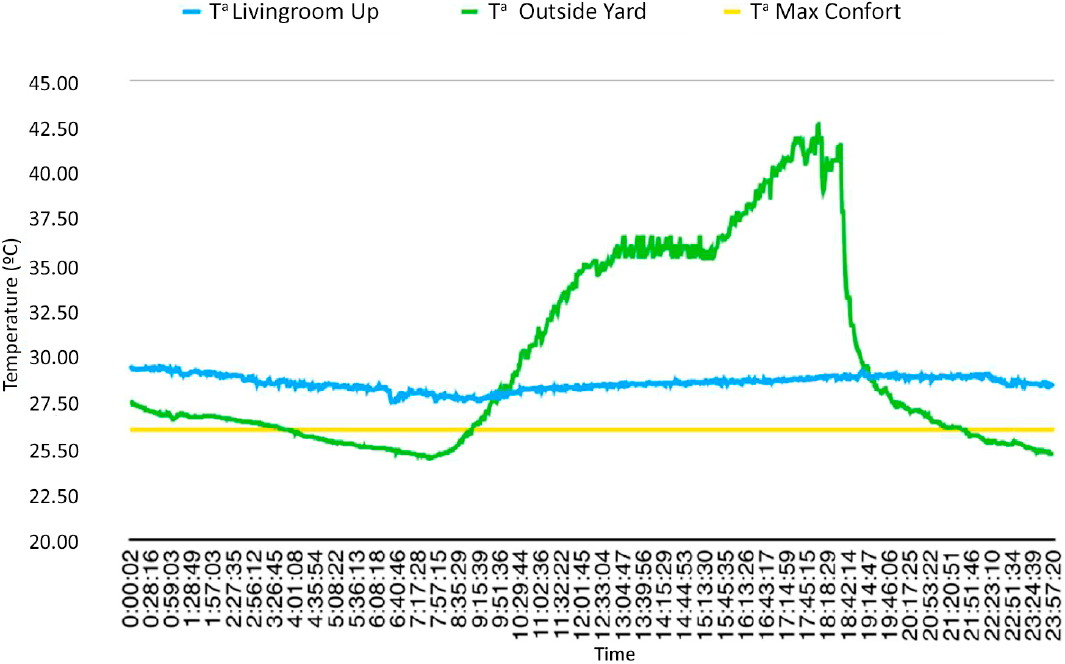
Figure 22. Variation in the dwelling indoor temperature opening windows and skylight.